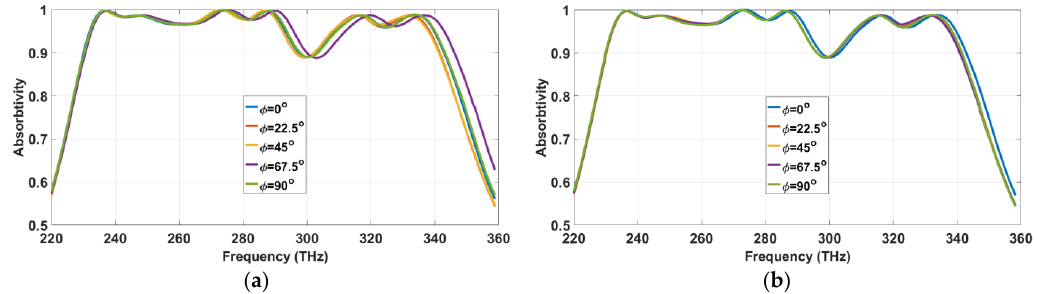
Figure 5. Polarization angle sensitivity at ( a ) the TE mode and ( b ) TM mode.